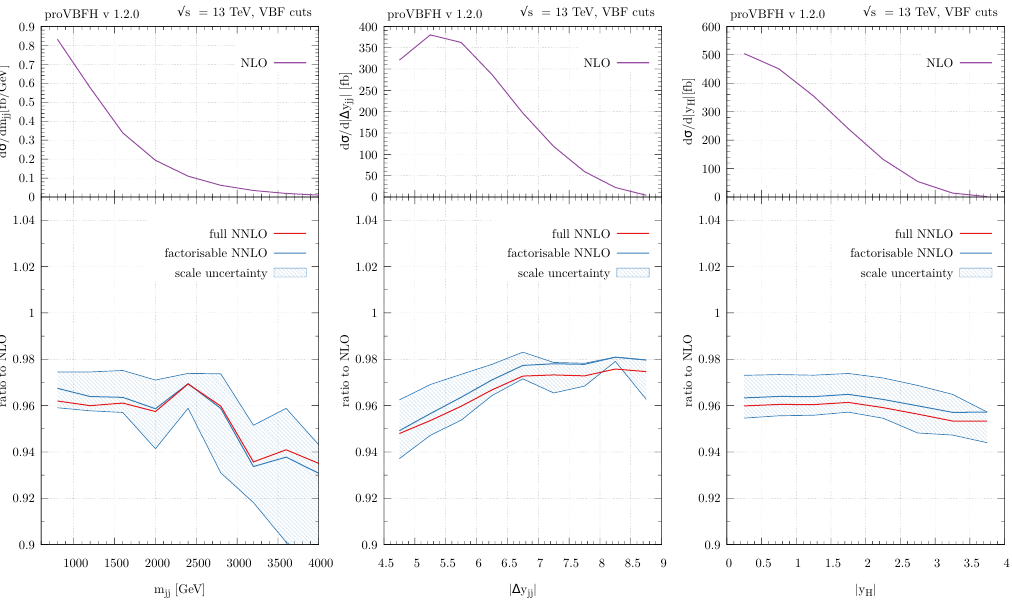
Figure 11. Upper panel: NLO prediction for VBF production with cuts for the invariant mass and rapidity separation of the tagging jets, as well as for the rapidity of the Higgs boson. Lower panel: ratio of the factorisable NNLO prediction to NLO (blue) and of the full NNLO prediction to NLO (red). The blue bands represent the scale uncertainty of the NNLO factorisable prediction. contributions from the large (cid:24) region. We observe that in the bulk of the phase space the numerical di(cid:11)erence between the red and the dashed-orange curves is very small | of the order of a few percent. It is therefore clear that the bulk of the non-factorisable corrections in the eikonal approximation come from the (cid:24) < 0 : 2 region, even without VBF cuts. This is consistent with (cid:12)gure 9 which shows that the mean value of (cid:24) is